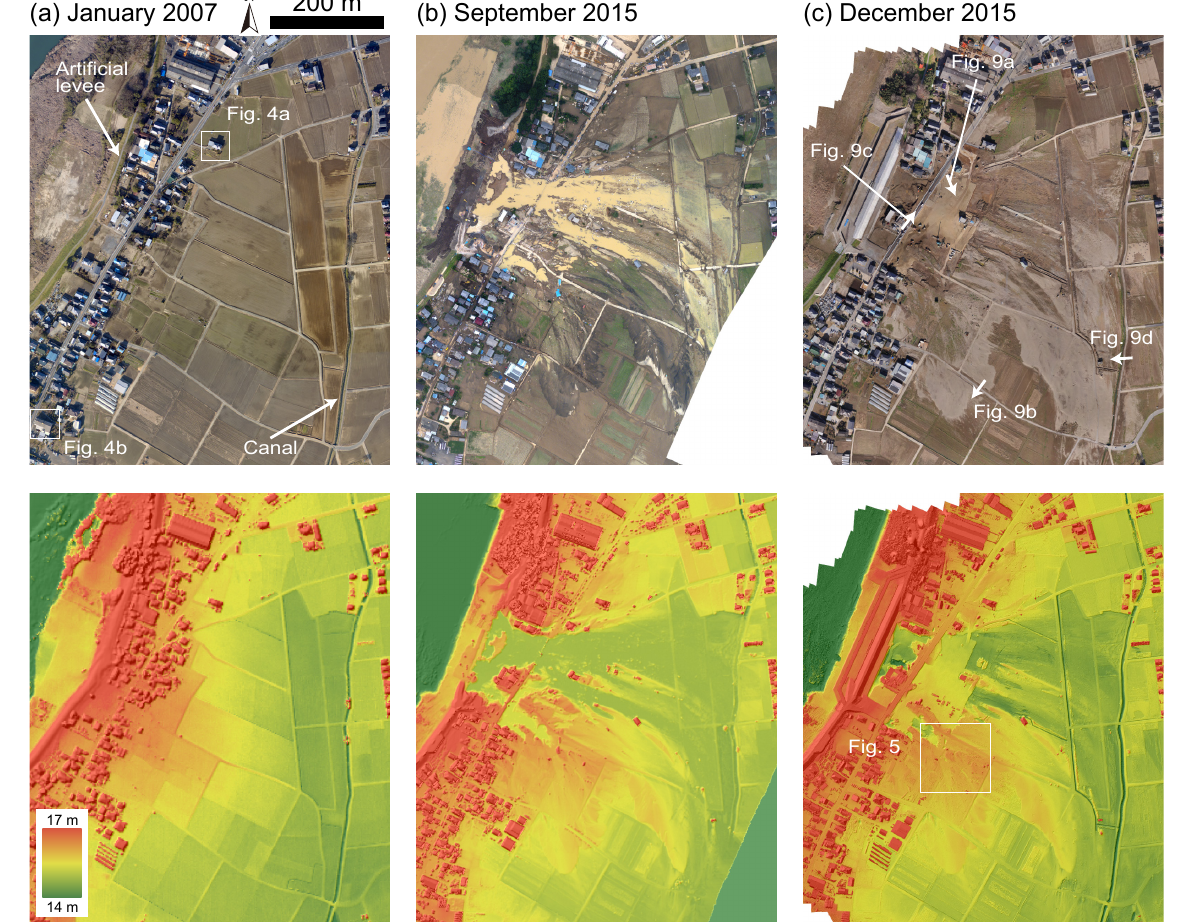
Figure 3. The three orthophotos (top) and DSMs (bottom) used in this study. See the text for information about the acquisition of each data set. Elevations are relative to mean sea level in Tokyo Bay. Note that the research area does not correspond to the areas of these